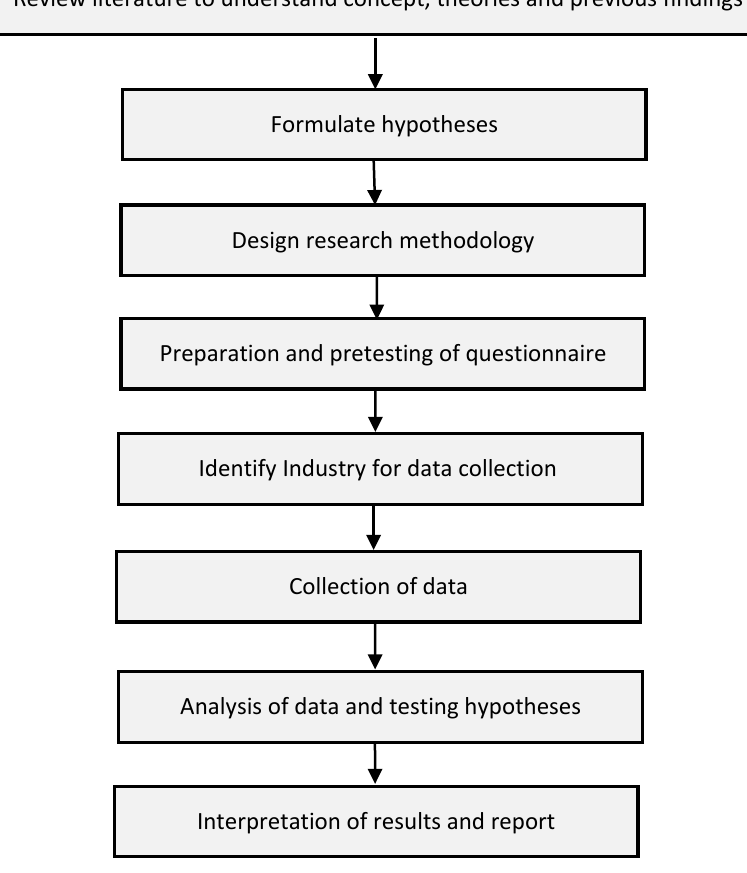
Fig. 1. Illustration of research methodology adopted for